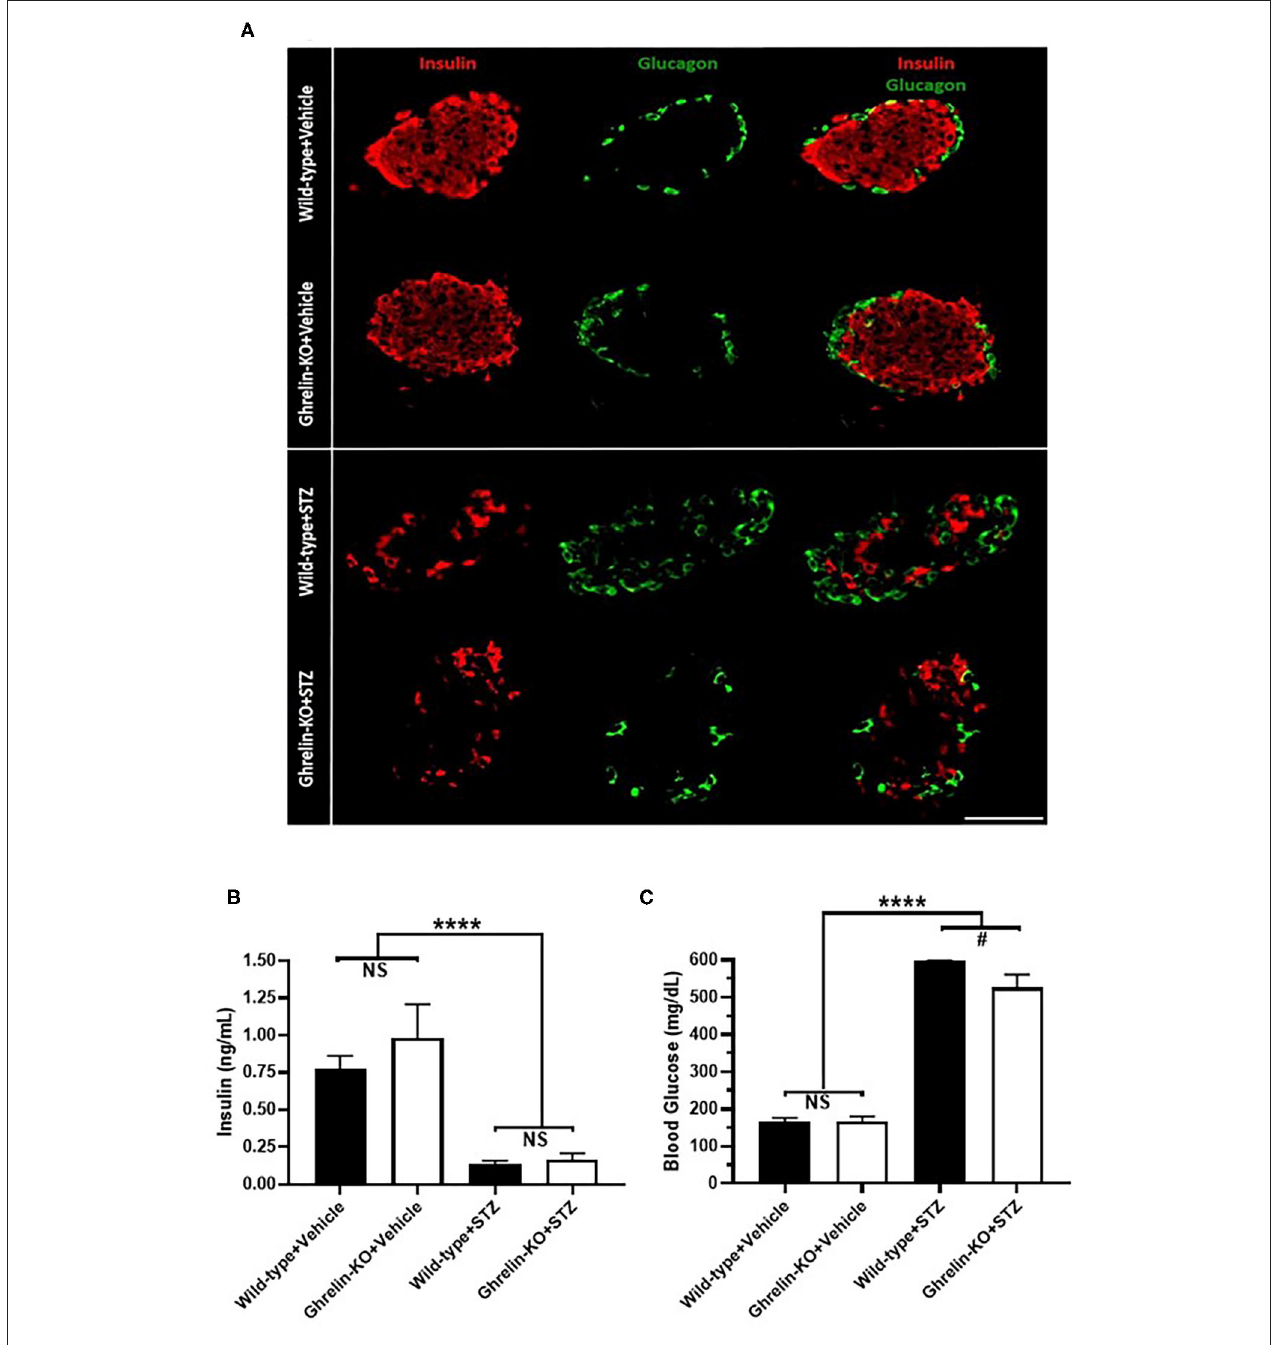
FIGURE 1 | Effects of STZ on islets, plasma insulin, and blood glucose in WT and ghrelin-KO mice. (A) A representative islet co-labeled for insulin-immunoreactivity (red) and glucagon-immunoreactivity (green) from a vehicle-treated WT mouse (1st row), a vehicle-treated ghrelin-KO mouse (2nd row), an STZ-treated WT mouse (3rd row), and an STZ-treated ghrelin-KO mouse (4th row). Scale bar = 100 µ m. (B) Ad lib -fed plasma insulin levels and (C) corresponding blood glucose levels in vehicle- and STZ-treated mice. Data are presented as mean ± SEM. n = 5–7. **** P < 0.0001, # P = 0.09, NS, no significant difference.